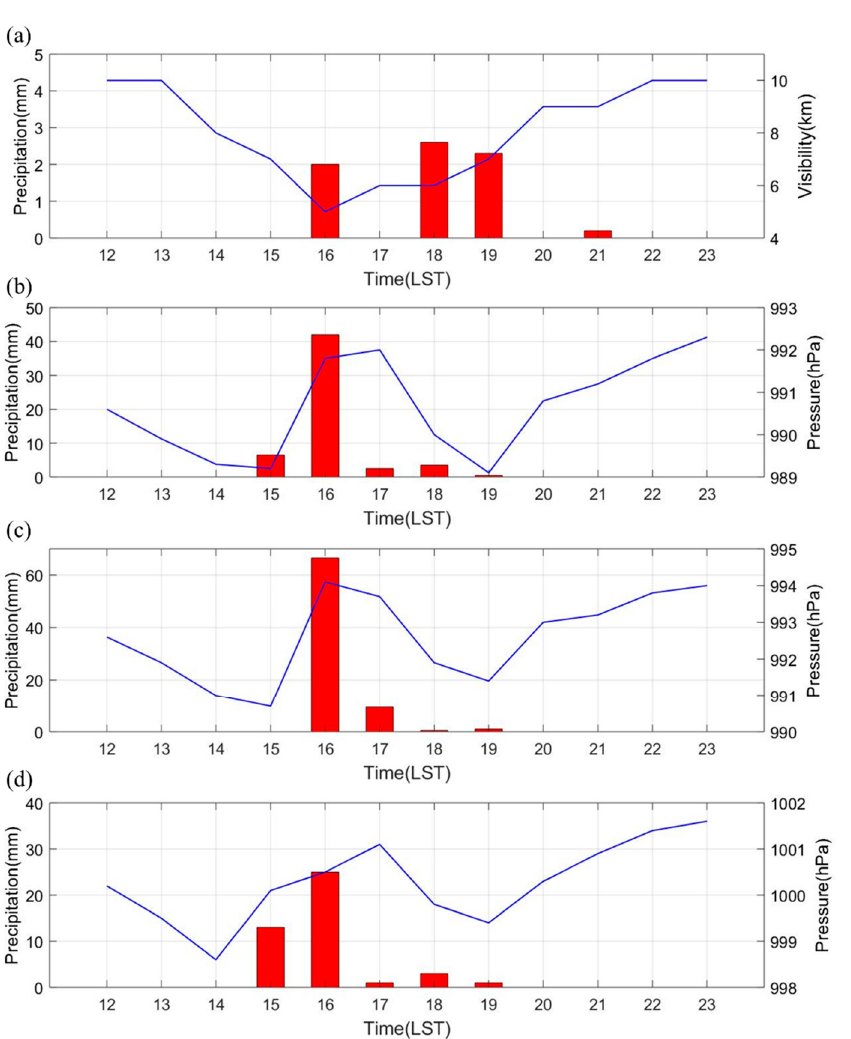
Figure 5. Observed hourly visibility (km; blue line) and accumulated precipitation (mm; red bar) at ( a ) Pingtung meteorological station, and observed hourly surface pressure (hPa; blue line) and accumulated precipitation (mm; red bar) at the ( b ) Cengwen, ( c ) Yuemei and ( d ) Yanpu AWSs from 0400 to 1500 UTC (1200 to 2300 LST) on 5 August 2018.